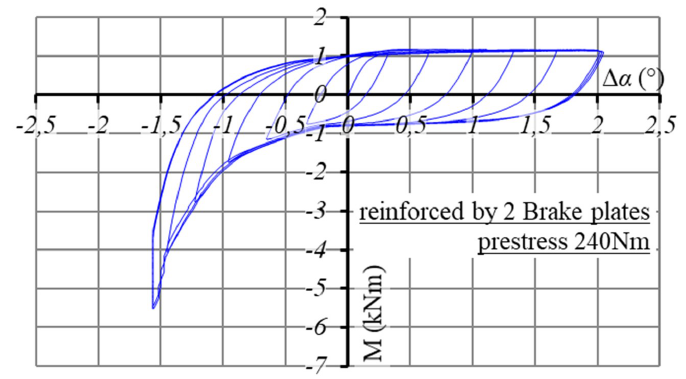
Buildings 2018 , 8 , x FOR PEER REVIEW Figure 10. Hysteresis loops of a joint retrofitted with brake plates. Figure 10. Hysteresis loops of a joint retrofitted with brake plates.